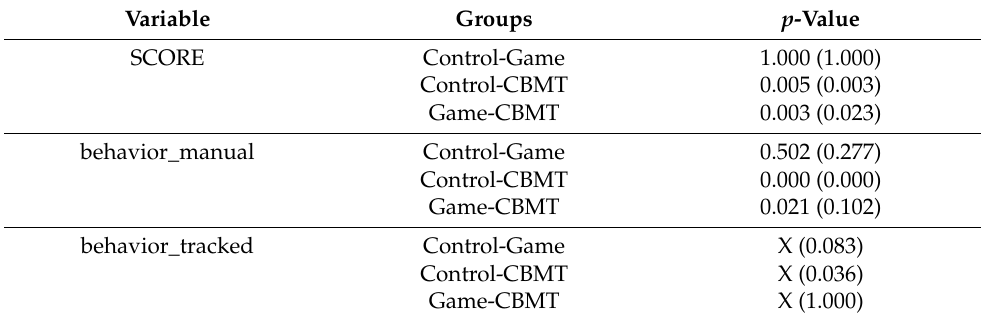
Table 5. Pairwise post hoc tests. Please note that post hoc tests for the variable behavior_tracked were only computed in the case when participants in the group Game, who did not play the game was omitted because the corresponding Kurskal-Wallis H tests was only significant in that